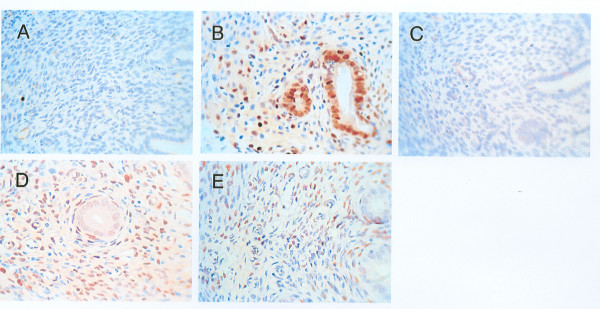
Effects of liarozole fumarate (R85246) in combination with tamoxifen on N-methyl-N-nitrosourea (MNU)-induced mammary carcinoma and uterus in the rat model. Immunohistochemical staining for PCNA in the uterus of rats obtained from OVX controls (A), 17β-estradiol 10 μg/kg (B), liarozole 80 mg/kg (C), tamoxifen 1 mg/kg (D) and liarozole 80 mg/kg + tamoxifen 1 mg/kg (E). Note the inhibitory effect of liarozole significantly negated the tamoxifen stimulatory effect on the PCNA staining (magnification, ×400).